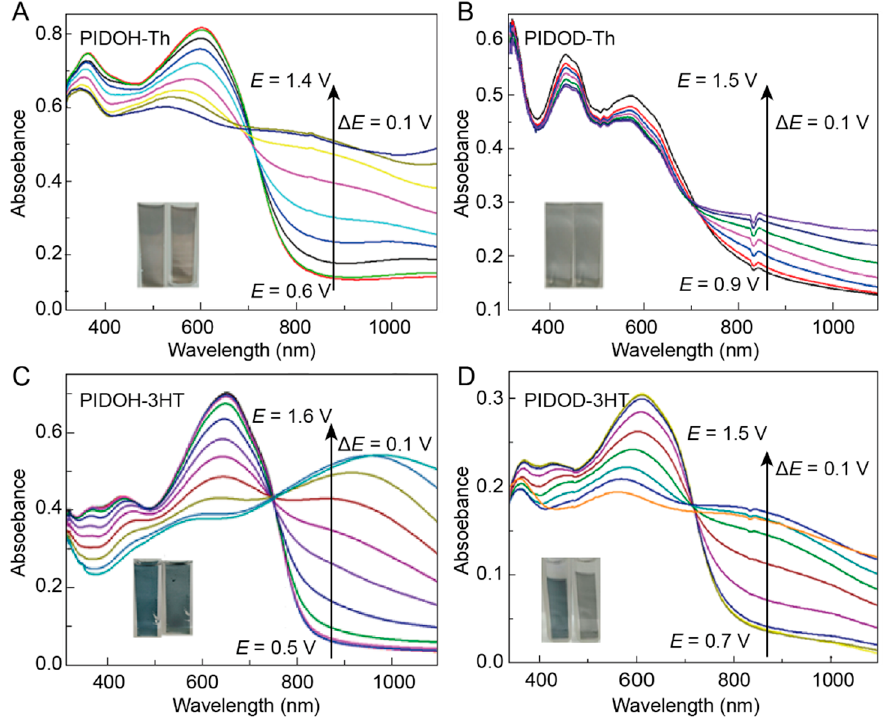
Figure 5. Spectroelectrochemistry and color-changing photographs (Inset) of PIDOH–Th ( A ), PIDOD–Th ( B ), PIDOH–3HT ( C ), and PIDOH–3HT ( D ) in precursor–free CH 3 CN–Bu 4 NPF 6 at the applied potentials of 0.6–1.4 V, 0.9–1.5 V, 0.5–1.6 V, and 0.7–1.5 V, respectively.